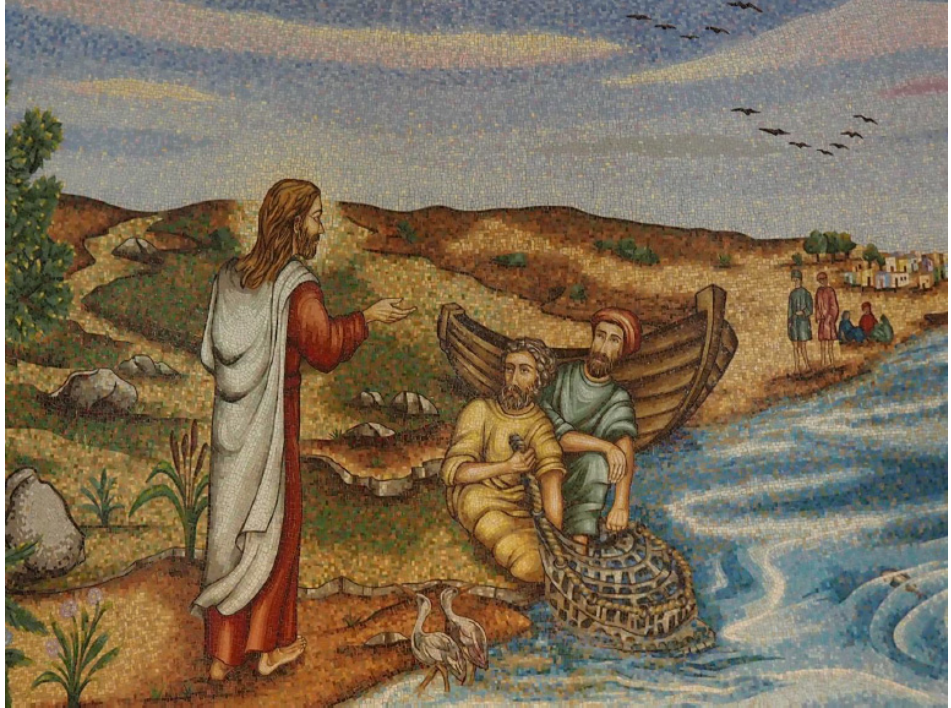
Figure 12. The Calling of Peter and Andreas (photo: Assaf